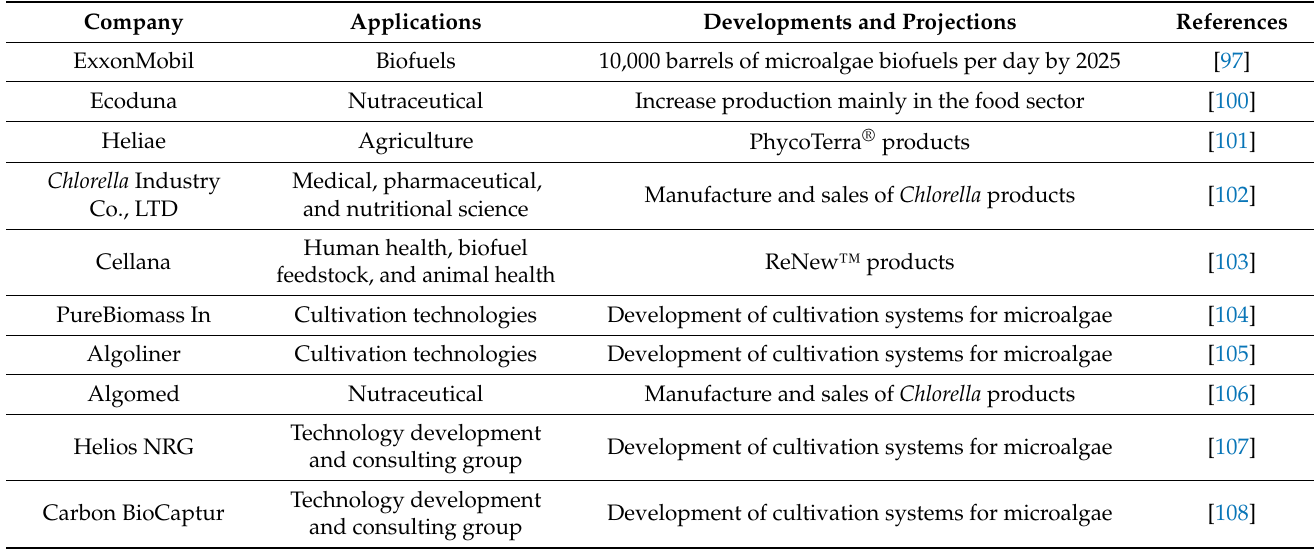
Table 2. Microalgal commercial